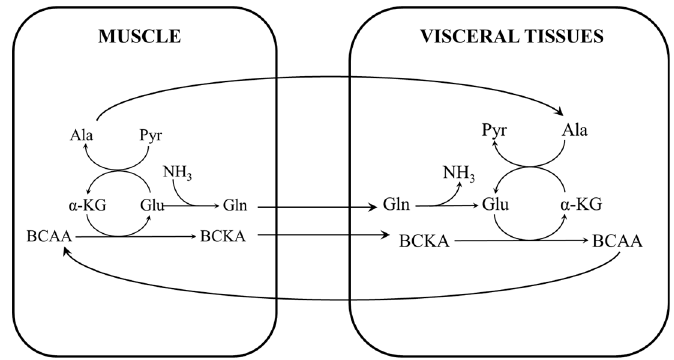
Figure 2. A scheme of the BCAA–branched-chain keto acid (BCKA) cycle between the muscles and visceral tissues. In the muscles, BCAAs are the main donor of nitrogen to α -KG to form glutamate, which may be converted to alanine or act as a substrate for GLN synthesis. The main sources of nitrogen for the amination of BCKAs to BCAAs in the visceral tissues are GLN, glutamate, and